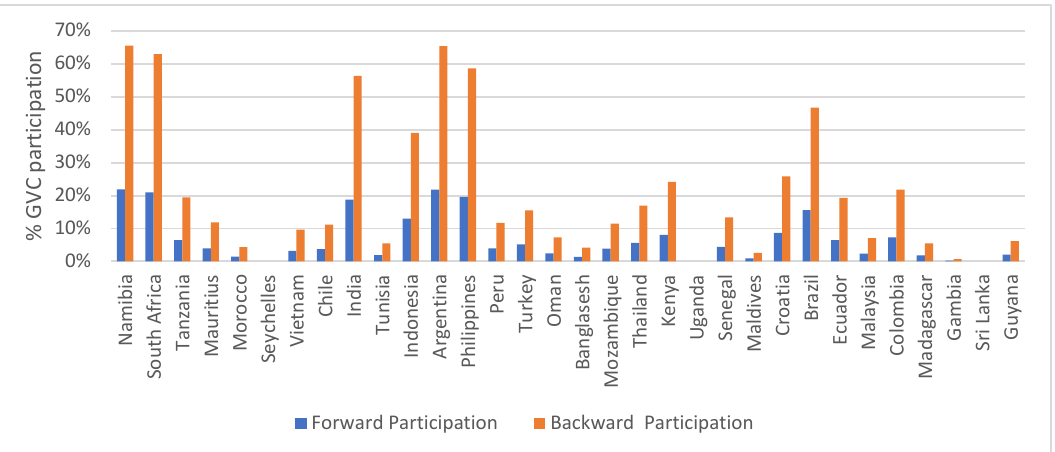
Figure 1. Forward and backward GVC participation (2009–2018). Source: UNCTAD–Eora Multi-Region Input–Output (https://worldmrio.com/unctadgvc/, accessed on 24 February 2022) database.